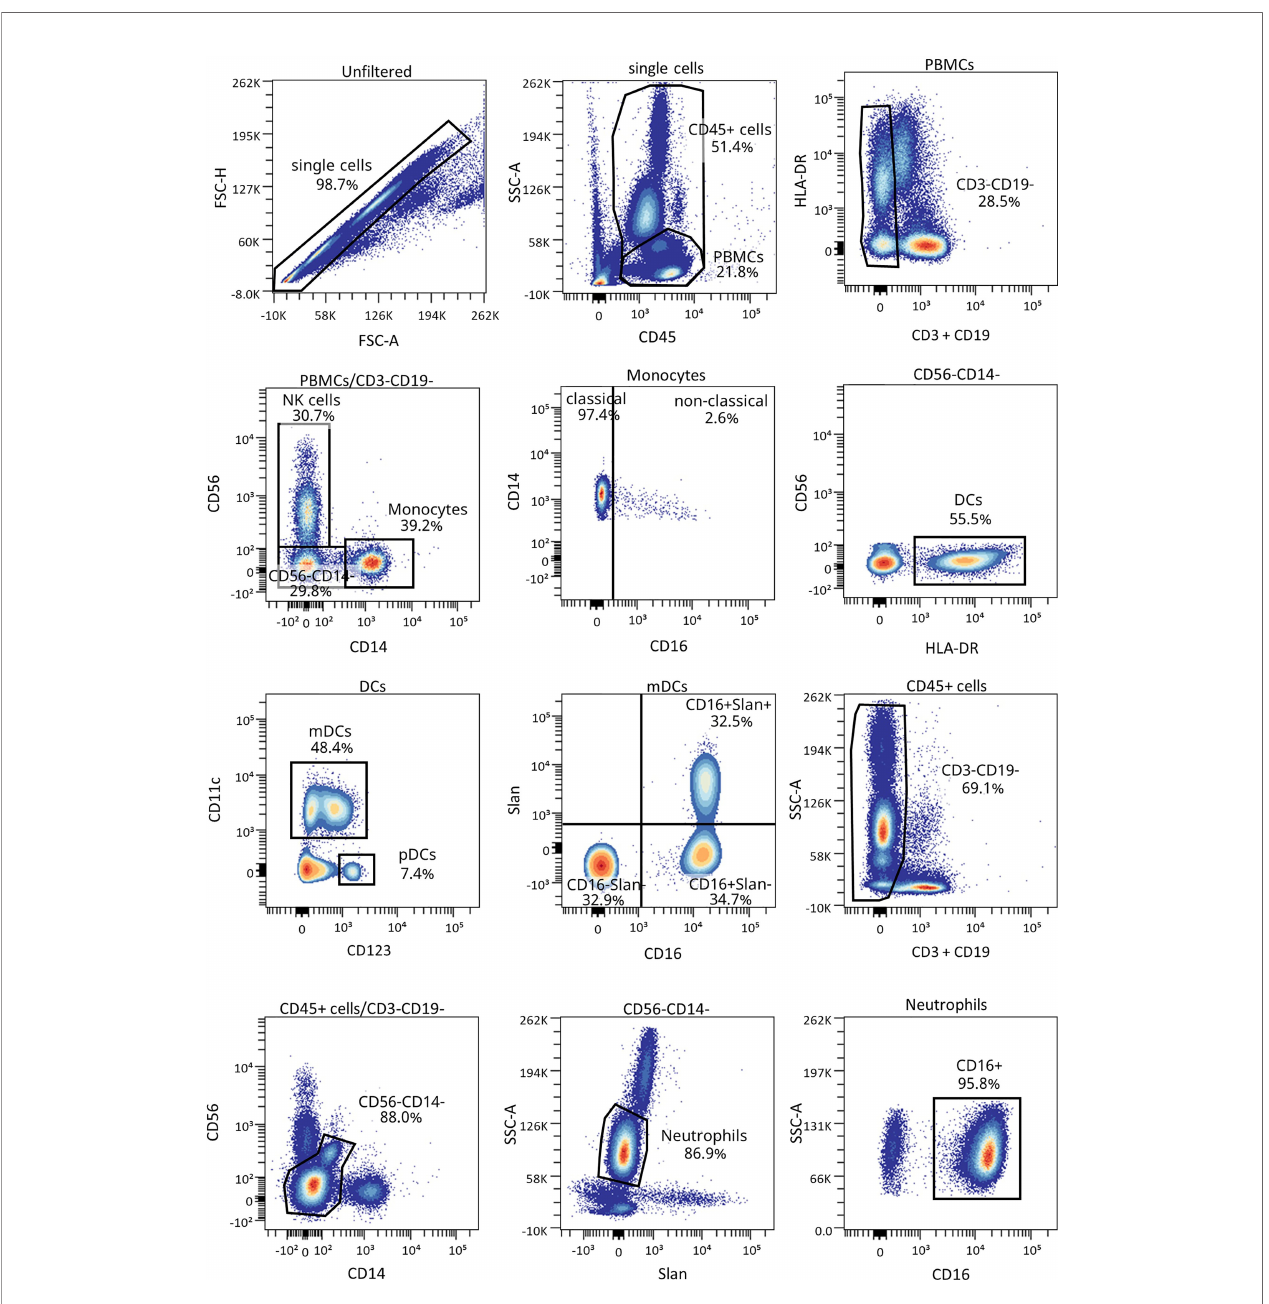
FIGURE 6 | Representative gating strategy for the innate cells panel. Gating strategy used to analyze the percentages of DCs, monocytes, and neutrophils. Cells were fi rst gated for singlets, PBMCs, and CD3 - CD19 - cells. With the use of CD56 and CD14, cells were divided into NK cells and monocytes, which were both further divided into their subsets with the use of CD16, and DCs (lineage negative and HLA-DR + ). Different subsets of DCs (mDC and pDC) were analyzed using CD123 and CD11c, and mDCs were further divided into their subsets with the use of CD16 and